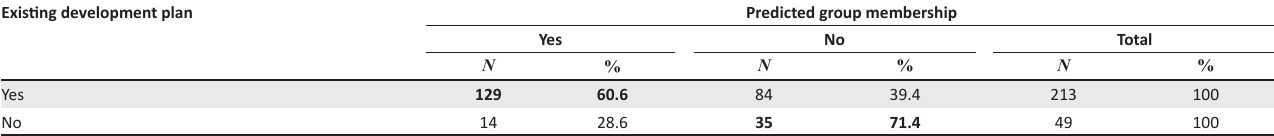
TABLE 9: Classification of results to determine the accuracy of predicted group membership. Existing development